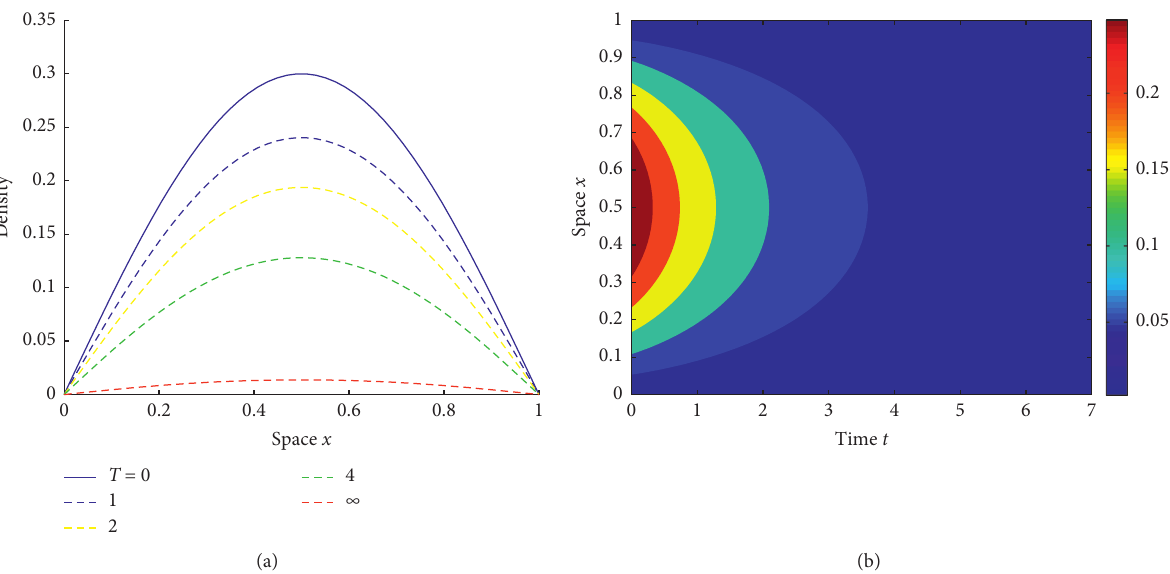
Figure 4: The corresponding cross-sectional view (a) and contour one (b) for the solution of problems (7) and (9), which implies that the domain is fixed when the evolution rate ρ ( t ) �